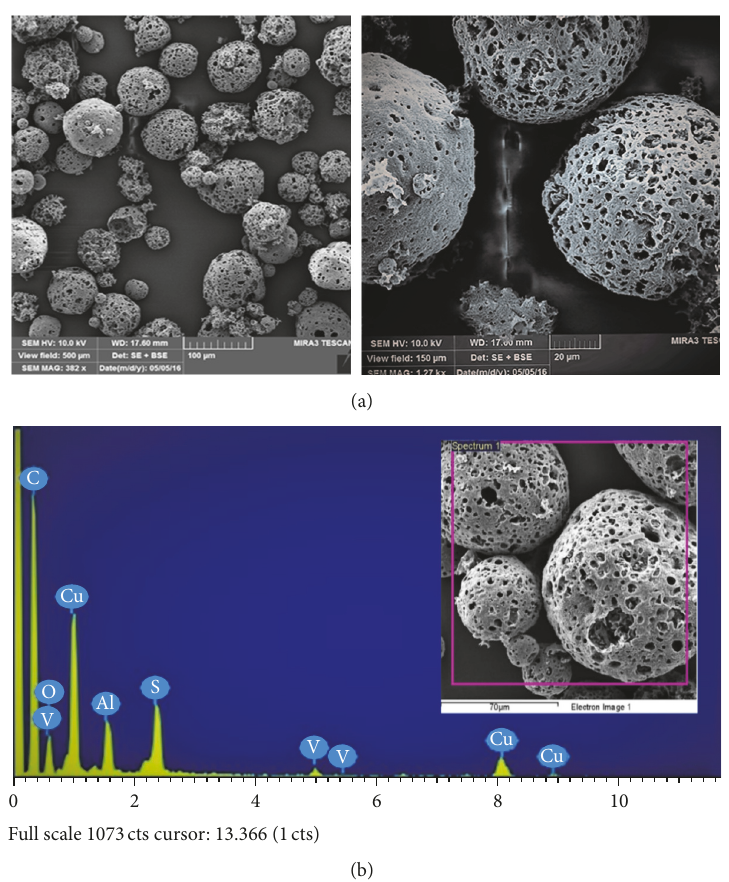
Figure 3: Raw FA (a) SEM micrographs (view field: 500 and 150 𝜇 m; voltage: 10 kV; resolution: 382x and 1.27kx); (b) EDX spectrum.